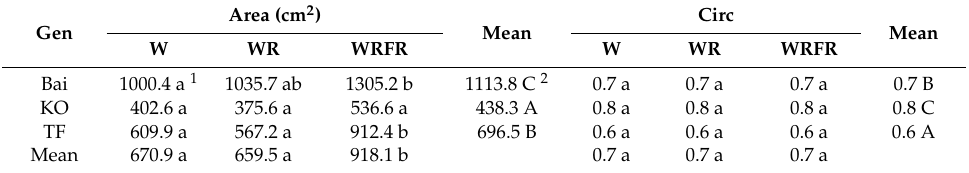
Area, area of the convex envelope; Circ, circularity. 1 Means followed by the same lowercase letter in the same line are not significantly di ff erent (Tukey test, p < 0.05). 2 Means followed by the same uppercase letter in the same column are not significantly di ff erent (Tukey test, p <